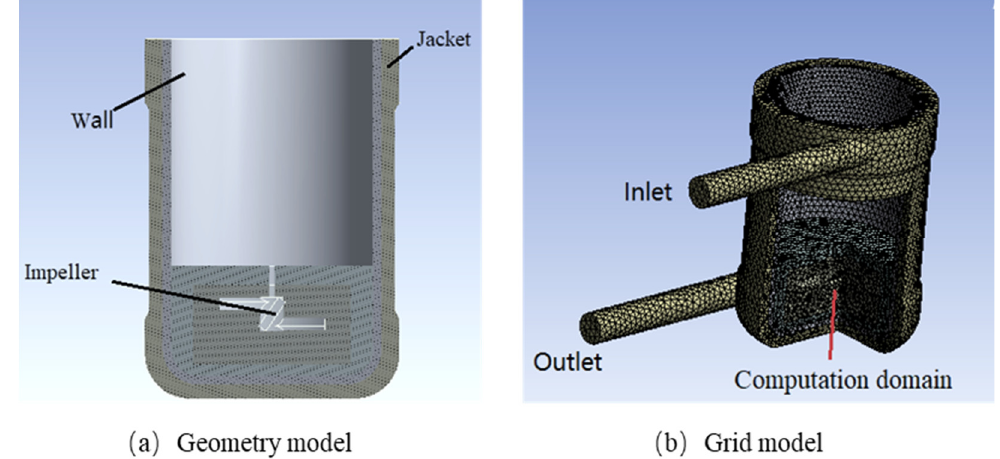
Figure 1. Physical model and grid division of the batch reactor.